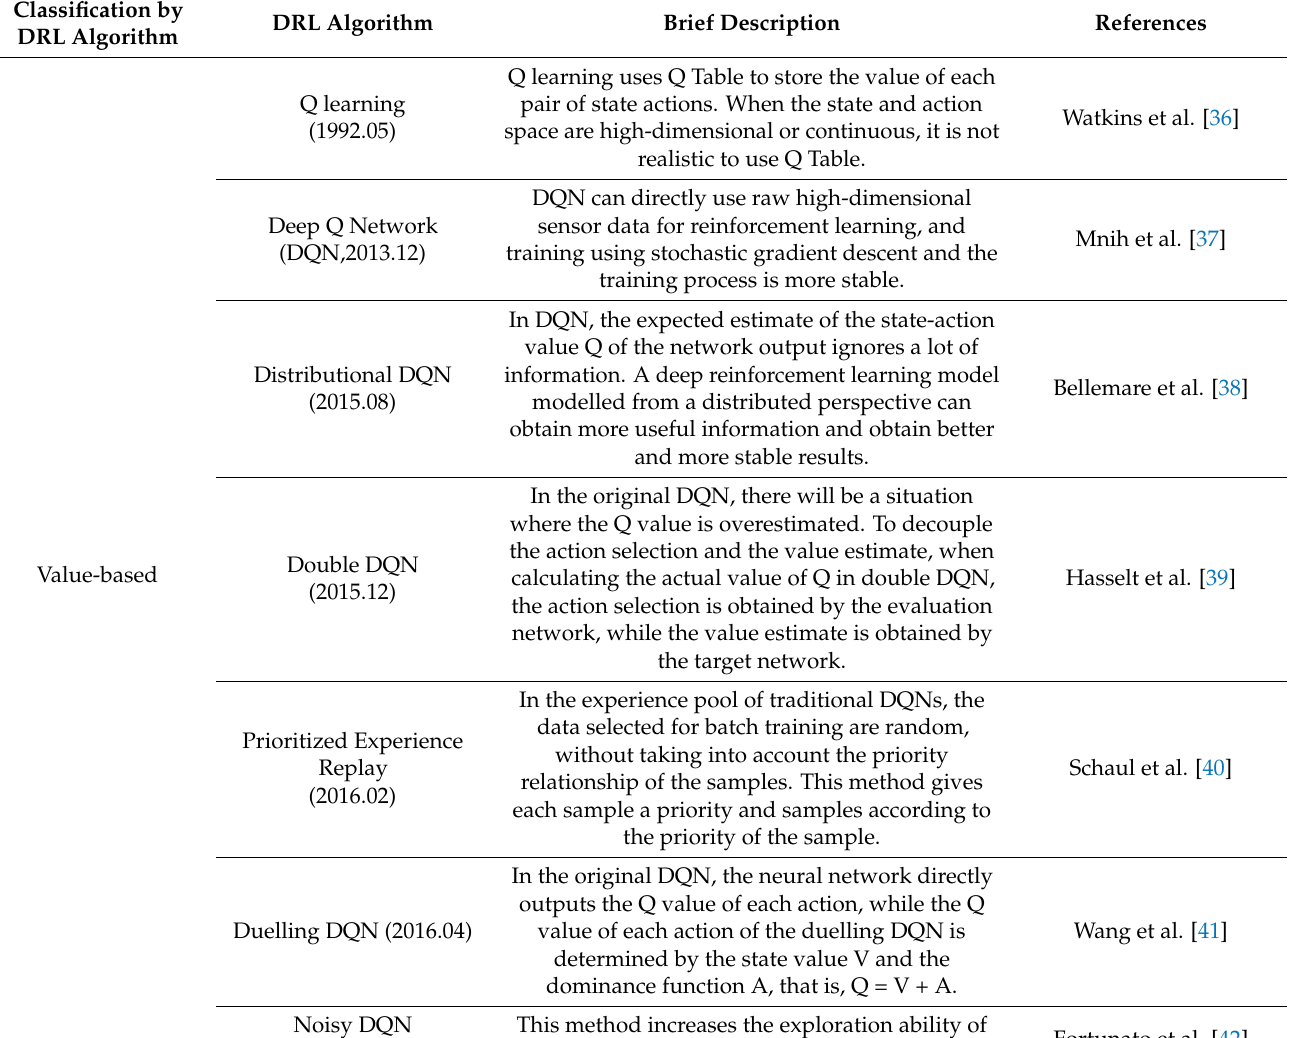
Table 1. Comparison of methods and results of research in related